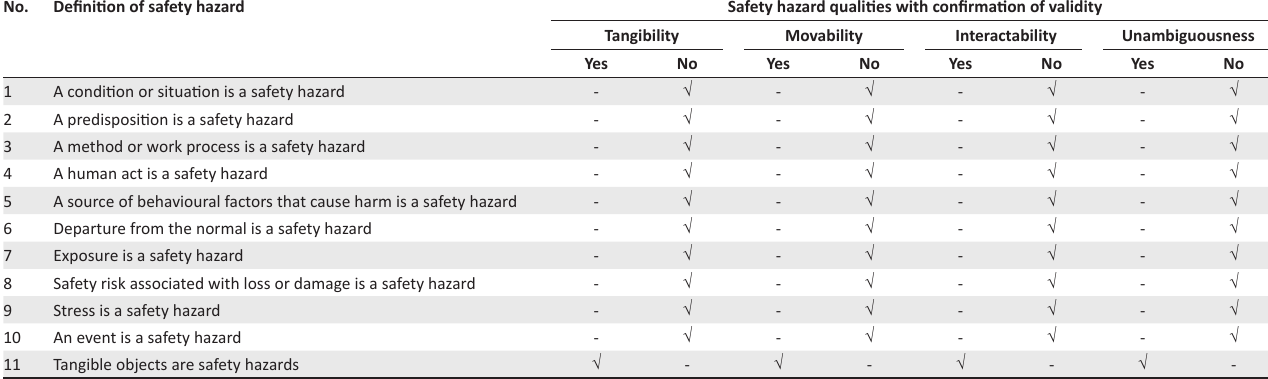
TABLE 1: Validity of current views on safety